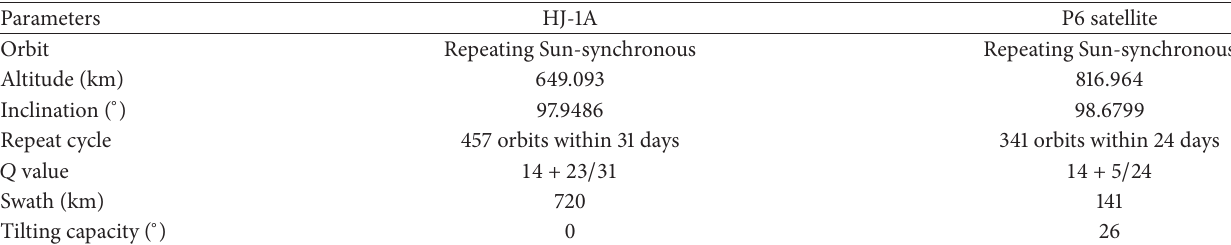
Table 4: The orbital parameters and mission characteristics of two satellites.